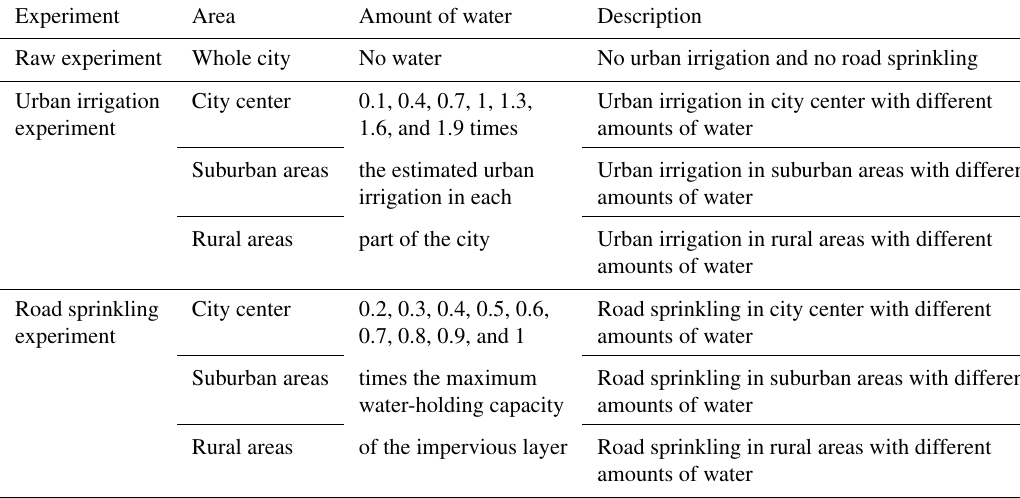
Table 2. Descriptions of experimental designs.